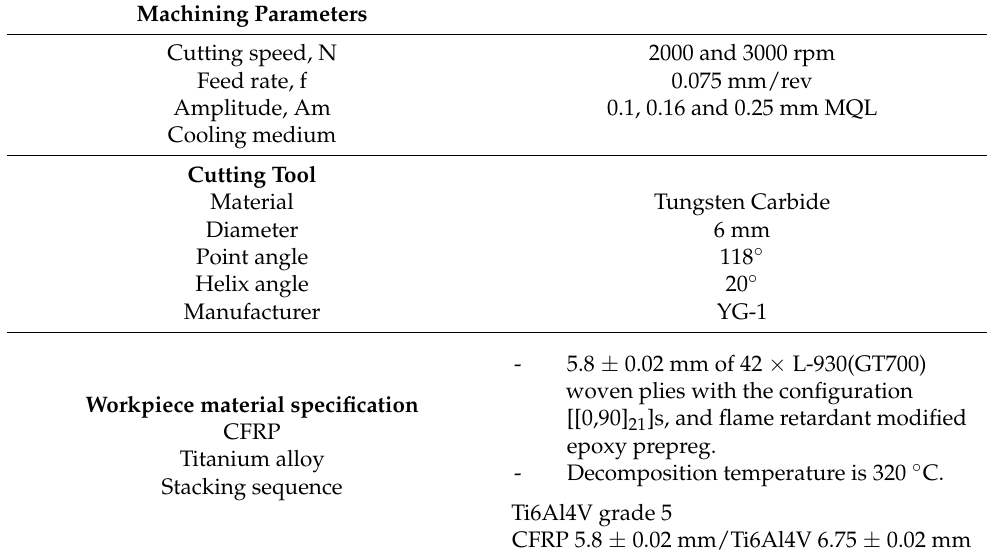
Figure 1. The experimental setup and workpiece materials. Table 1. Specification of machining parameters, tool, and workpiece.